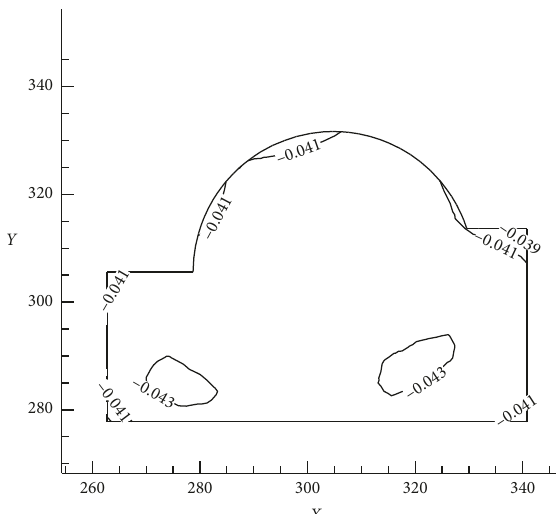
Figure 14: Settlement contour plots of rafts with different pile diameters (scheme 2)